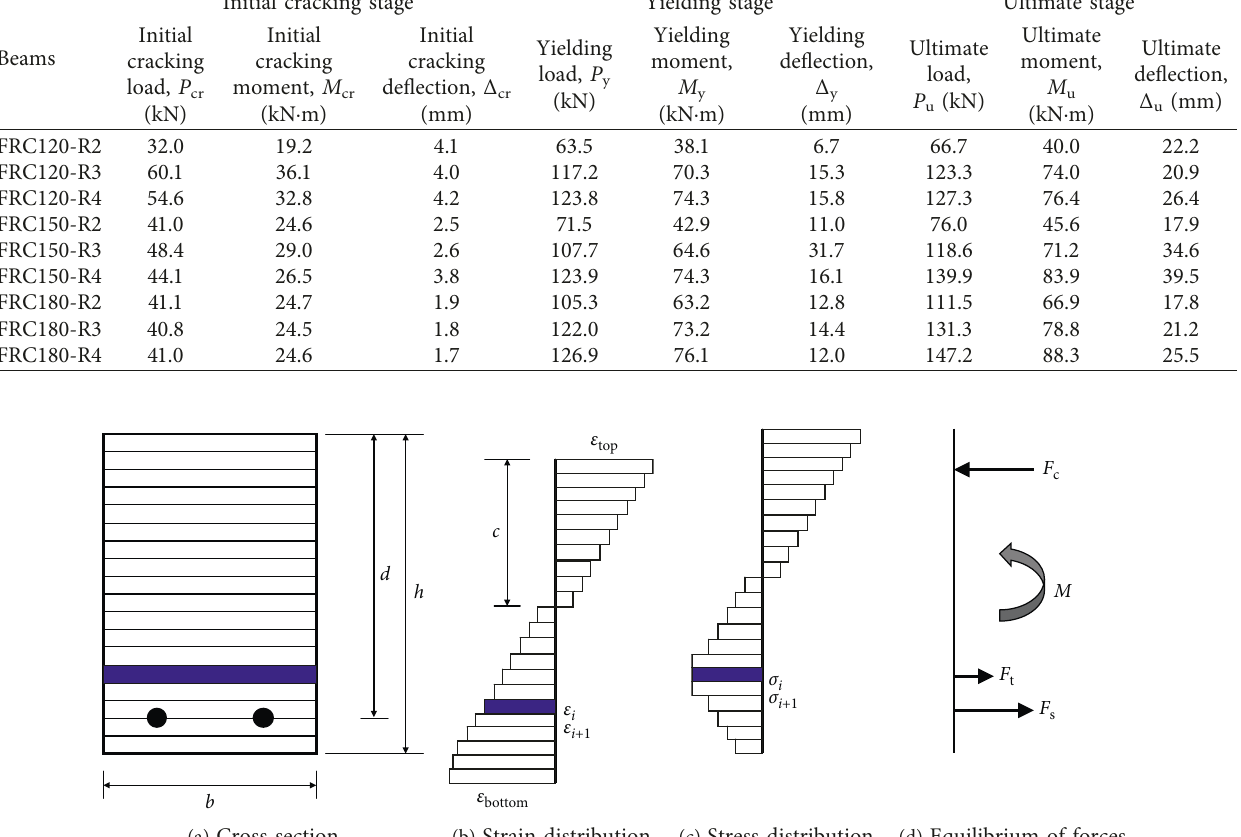
Figure 10: Strain compatibility and equilibrium forces in sectional